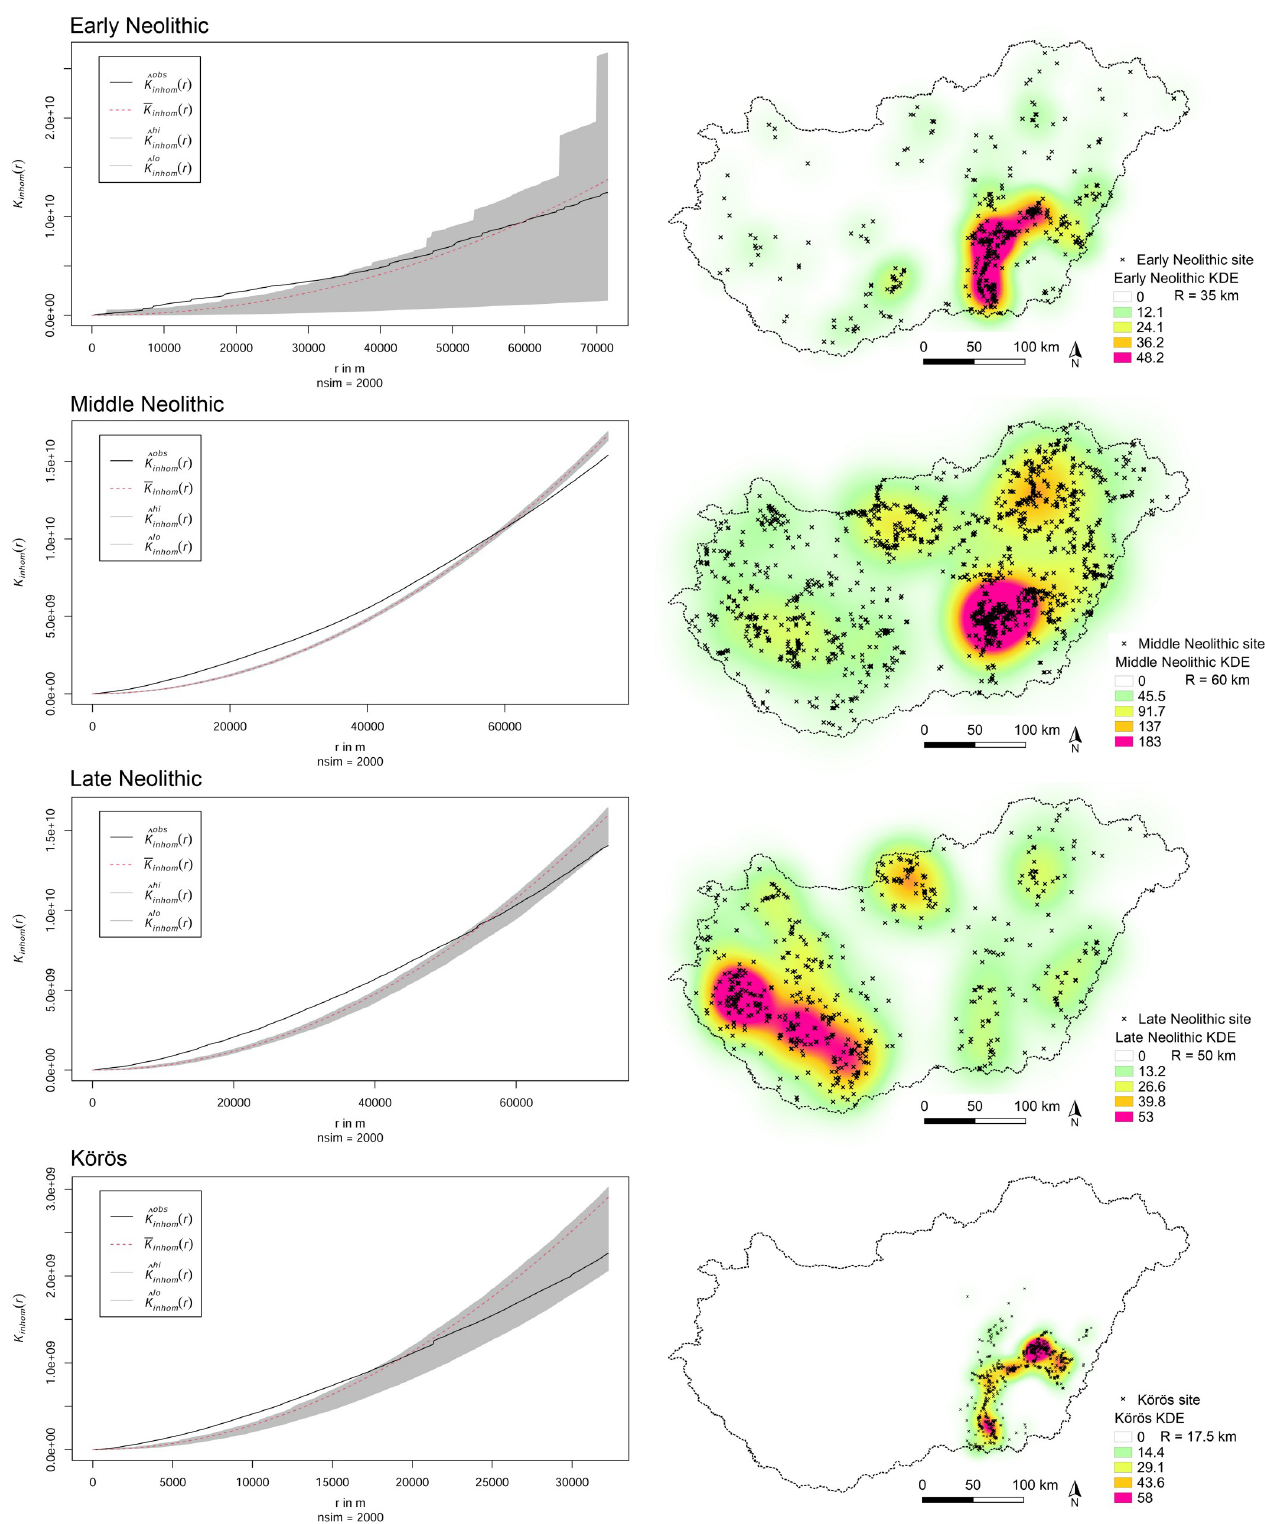
Fig 5. Ripley’s K-Function and Kernel Density Estimates (KDE) for early, middle and late Neolithic, and the ko¨ro¨s comparison dataset at different bandwidths. The KDE shows regional site continuity in the river Tisza region from the Early to the Middle Neolithic and a strong spatial shift towards Transdanubia during the Late Neolithic